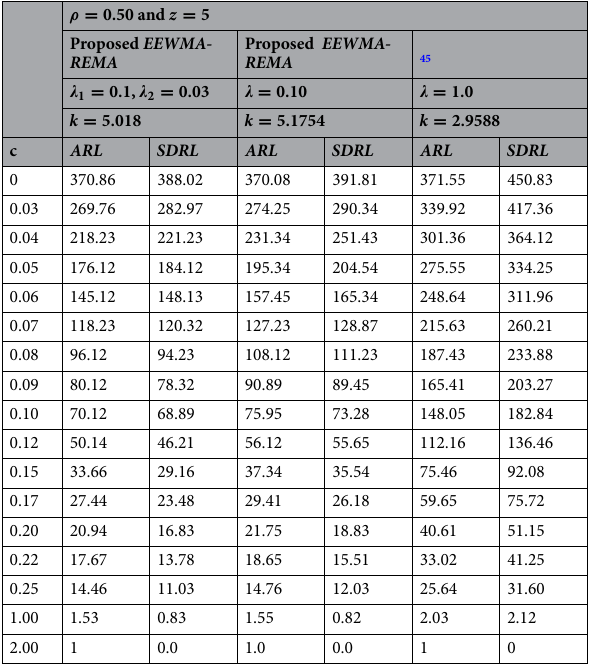
Table 11. Comparisons of the proposed EEWMA-REMA and EWMA-REMA control charts using auxiliary information versus 45 when ARL 0 = 370, n = 5 .